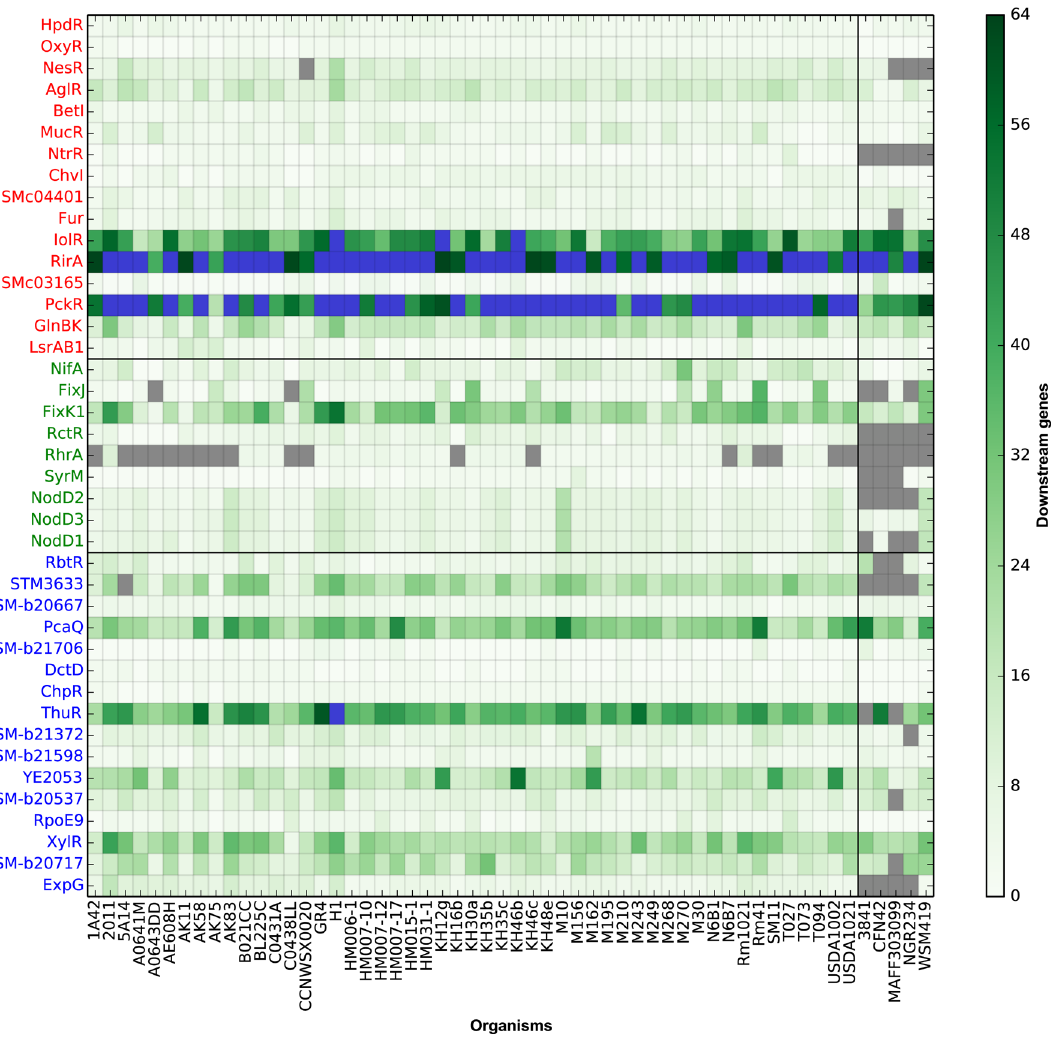
Fig 2. Variability in regulon size. Color intensity indicates the number of downstream regulated genes in each strain; gray squares indicate the TF absence in the genome of that particular strain. Blue squares indicate that there are more than 64 genes predicted to be under the control of the TF. TFs are colored according to the replicon they belong to: red for chromosome, green for the pSymA megaplasmid and blue for the pSymB